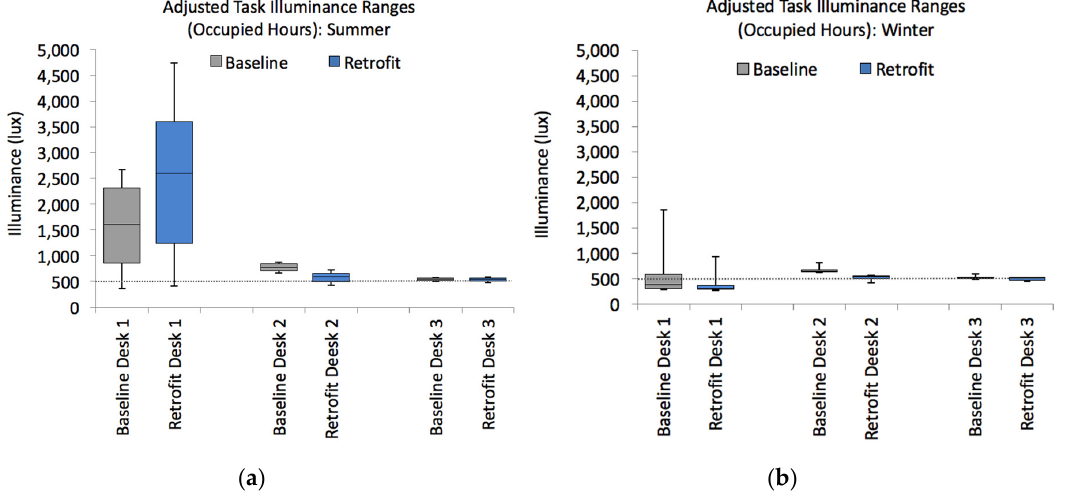
Figure 6. Box and whisker plots of baseline and retrofit horizontal illuminance data distributions on the three desks in the test space, for the full window height, existing building baseline (FWEB) test configuration: ( a ) summer test period; ( b ) winter test period. The plots illustrate 5th and 95th percentile values at the whiskers, and first and third quartile values at the box boundaries, and median values at the box inner line. The data were adjusted via post-processing as described in text above to achieve design target for Desk 2, the desk in the center cubicle.